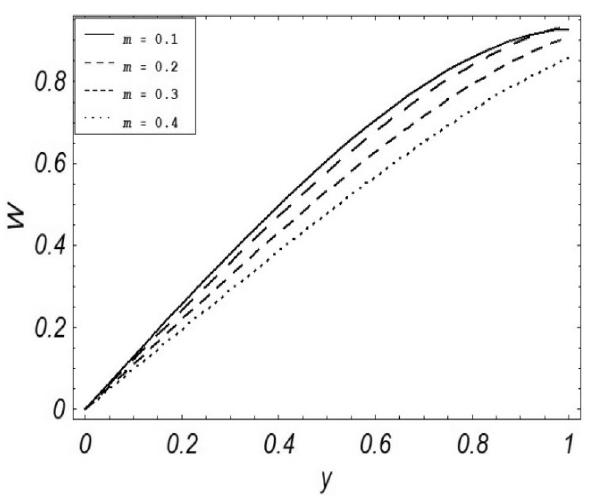
Figure 11. Evolution of W with various values of m if t = 1 ; Gr = 2.5 ; N = 0.7 ; K = 0.5 ; η = 2 � = 0.5 ; Re = 1 ; M = 0.1 ; ω = 0.5 ; ε = 0.001 ; α = 0.5 .